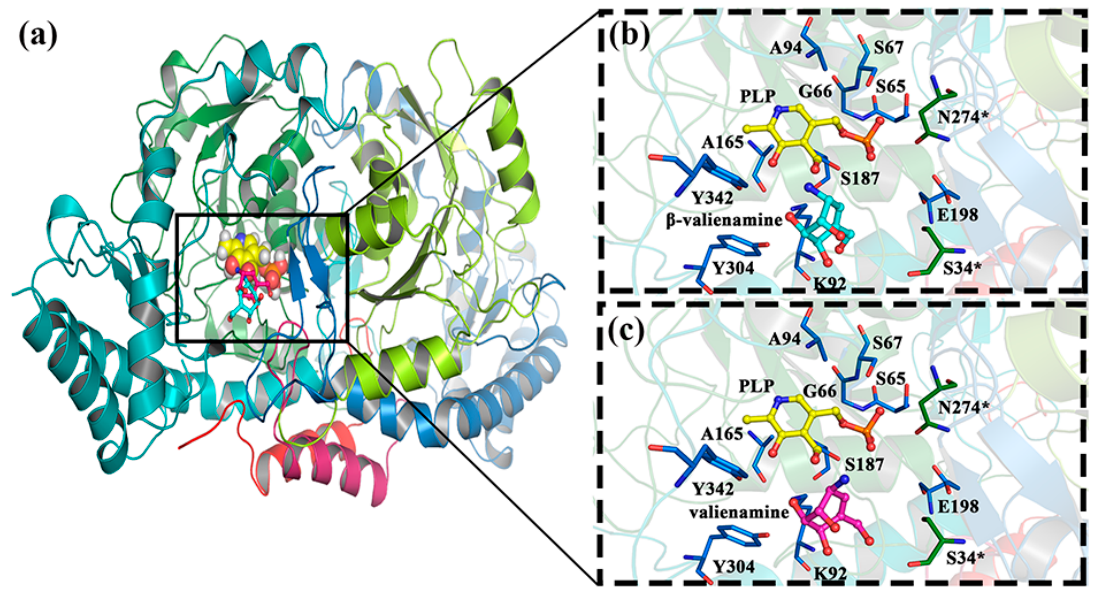
Figure 2. The results for docking using AutoDock Vina. ( a ) Comparison of docking results of β -valienamine and valienamine. ( b , c ) Close display of docking results. The residues in chain A that surround substrates and PLP are colored by marine, while they are colored by forest in chain B. β -valienamine, valienamine, and PLP are highlighted by cyan sticks, pink sticks, and yellow sticks, respectively.